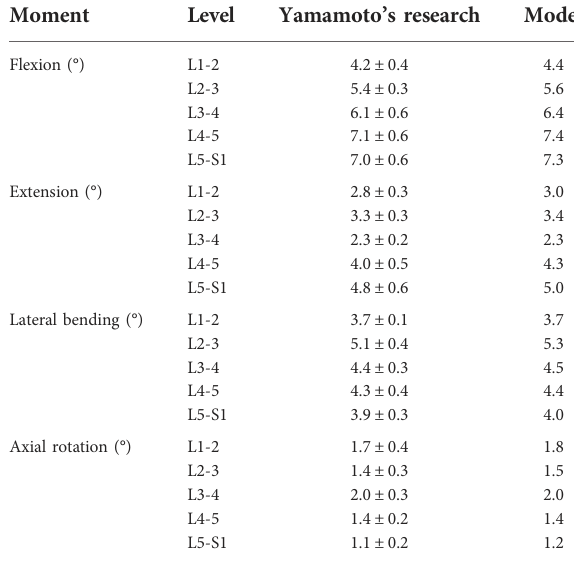
TABLE 5 Comparison of range of motion between the fi nite element model and the cadaveric study by Yamamoto et